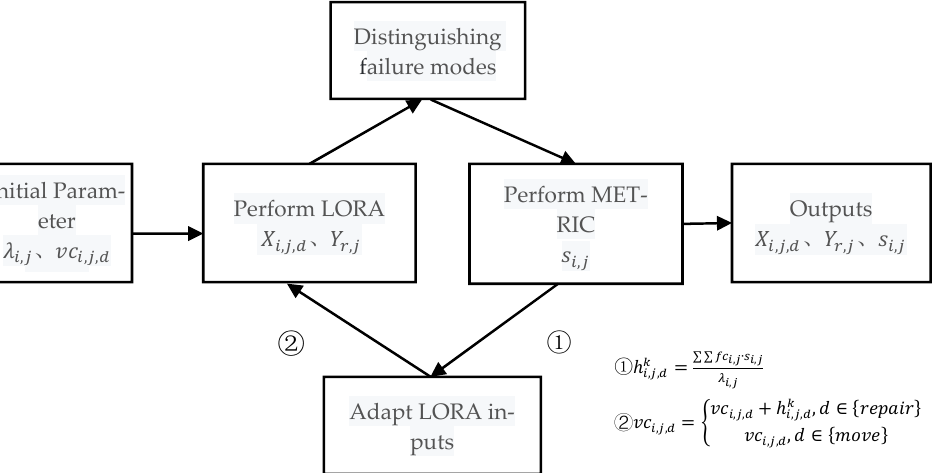
Figure 4. Joint iterative optimization method.